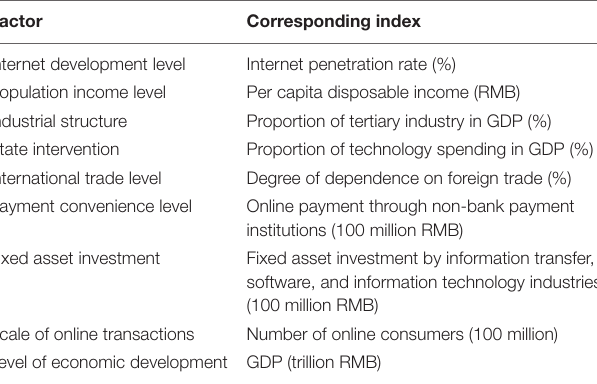
TABLE 6 | Factors affecting digital trade development level in China.